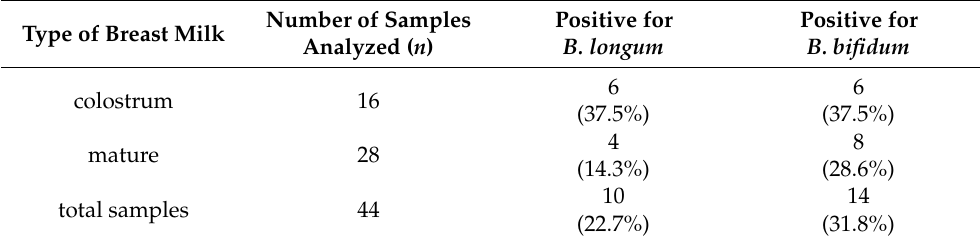
Table 3. Realtime PCR detection of the probiotic species Bifidobacterium longum and Bifidobacterium bifidum in human breast milk.